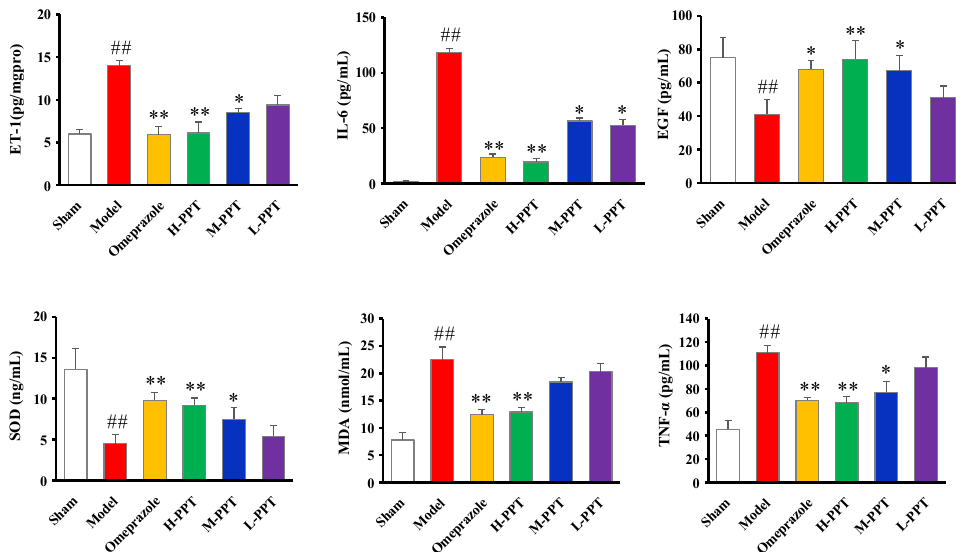
Figure 3. Biochemical estimations in serum evaluated the effects of different groups against GU. The ET-1, IL-6, EGF, SOD, MDA and TNF- α levels in serum. (Compared with the sham group, ## p < 0.01; compared with the model group, * p < 0.05, ** p < 0.01).